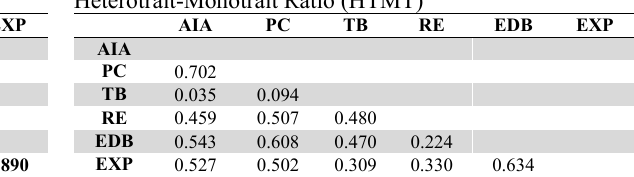
Fornell-Larcker Scale Heterotrait-Monotrait Ratio (HTMT)